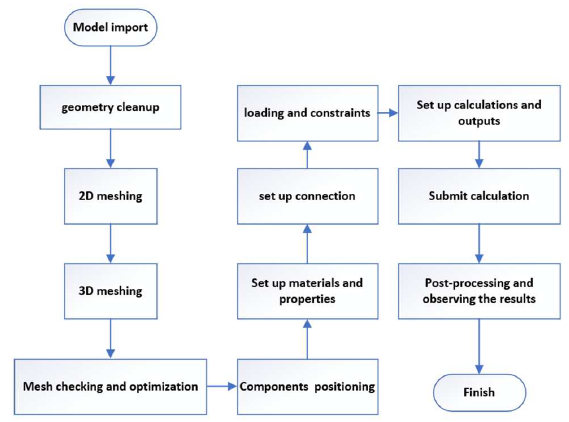
Figure 8. The establishment process of whole vehicle FEM.